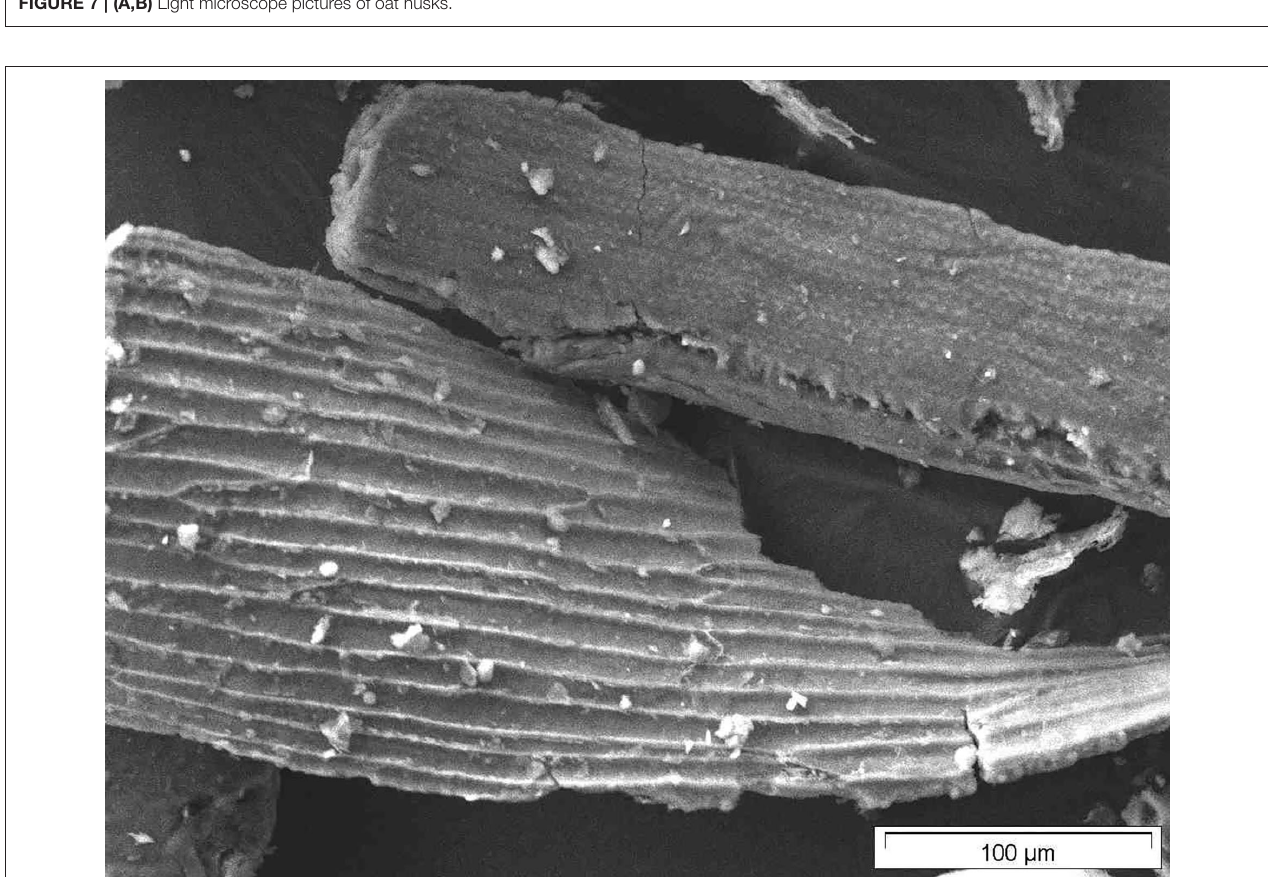
FIGURE 8 | SEM micrograph of out husk (just dried).